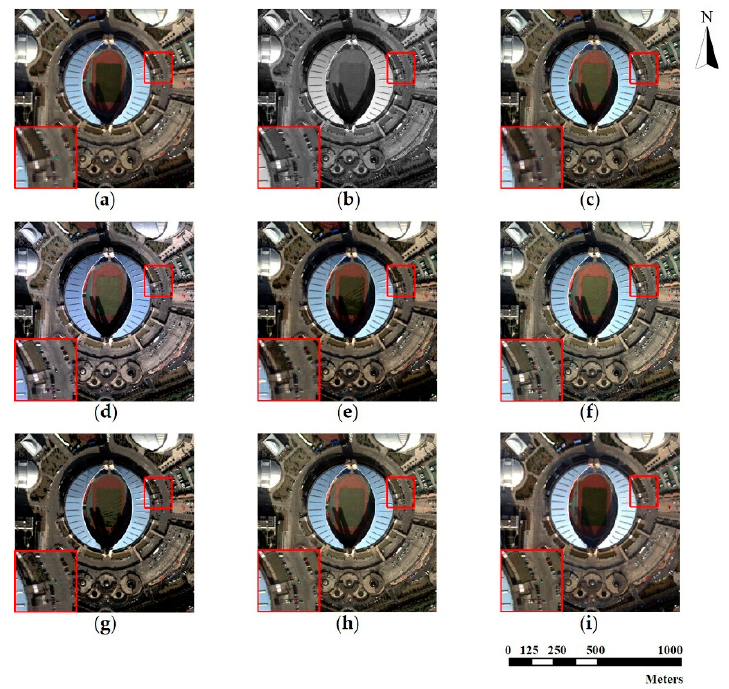
Figure 3. WorldView-2 original images and fusion results of different methods. ( a ) Original multispectral image (MS); ( b ) Original panchromatic image (PAN); ( c ) Gram-Schmidt [15] pan-sharpened image (GS); ( d ) Adaptive IHS [13] pan-sharpened image (AIHS); ( e ) Wavelet transform and sparse representation method [66] pan-sharpened image (WT-SR); ( f ) Wavelet-based IHS [19] pan-sharpened image (WT-IHS); ( g ) Curvelet transform and independent component analysis [67] pan-sharpened image (CT-ICA); ( h ) Ripplet transform based on injected details [23] pan-sharpened image (CSI); ( i ) pan-sharpened image by the proposed method (proposed).